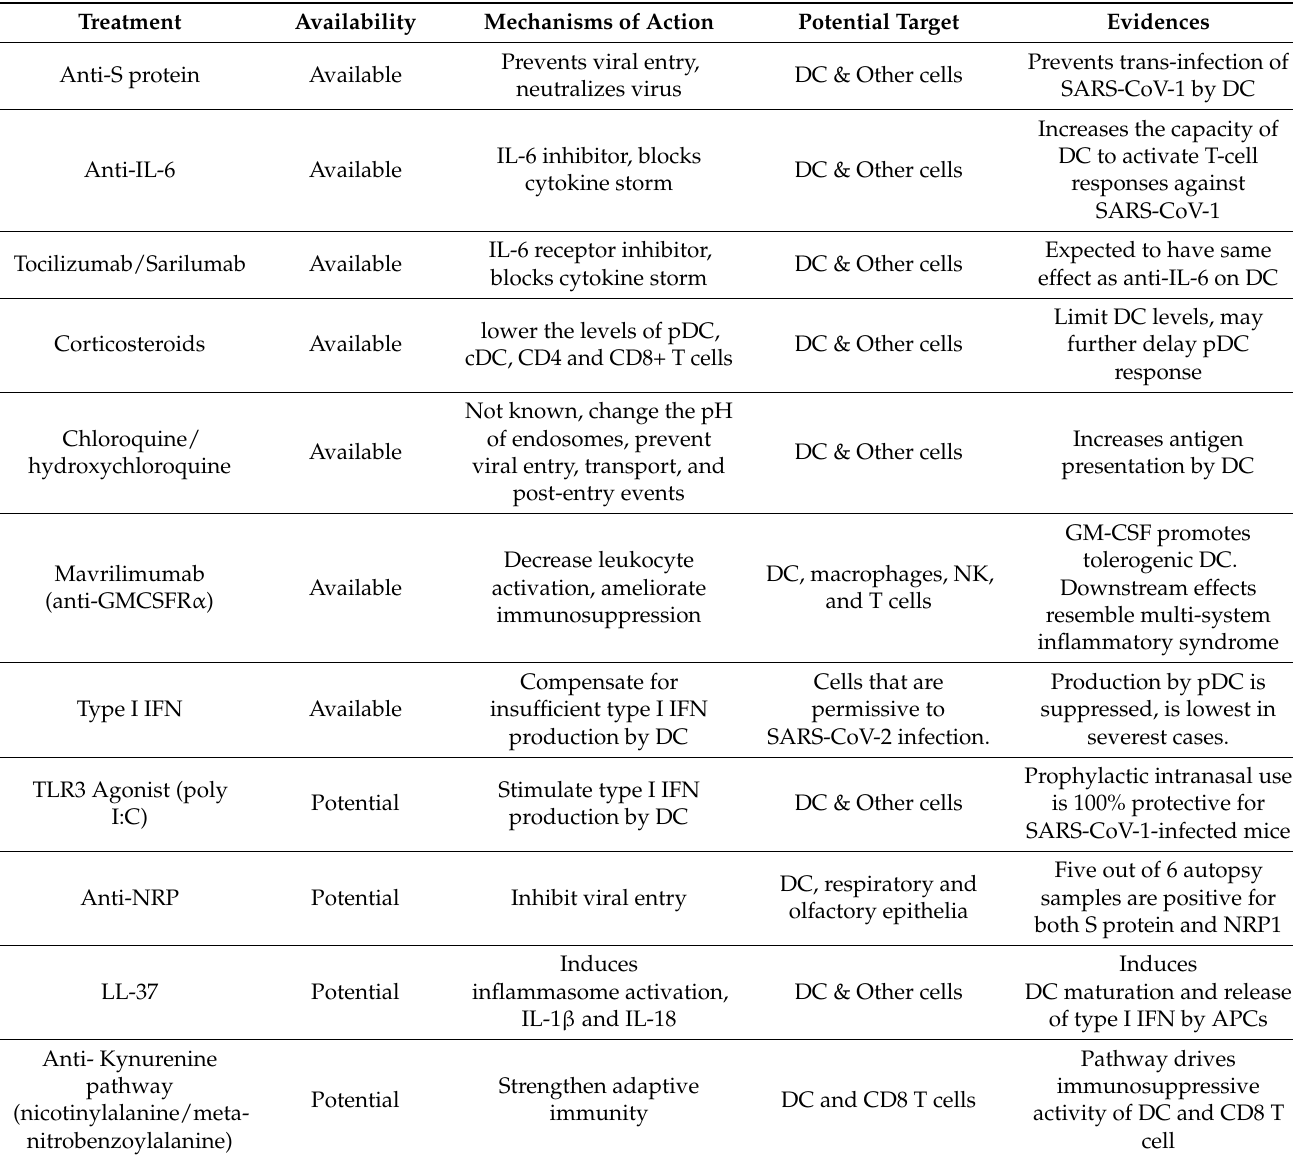
Table 2. Current and potential drugs affecting DCs in SARS-CoV-2